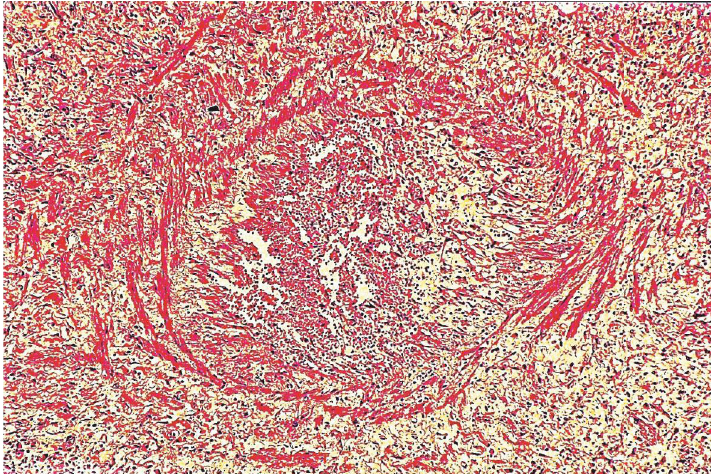
Figure 32: Vasospastic venous angiopathy. Edematous fl uid, released from the lysed muscle cells, containing newly forming granulation tissue and cellular debris widely separates surviving medial and adventitial muscle and compresses and disrupts the intima. Hematoxylin & eosin × 100 (adapted from the World Journal Cardiovascular Diseases 2013.3 published